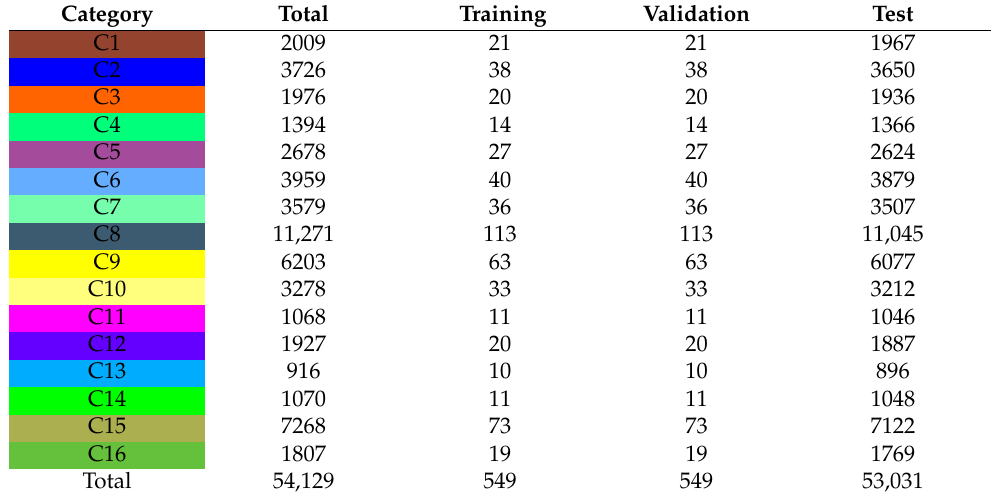
Table 2. Category information and corresponding experimental sample size for SV.